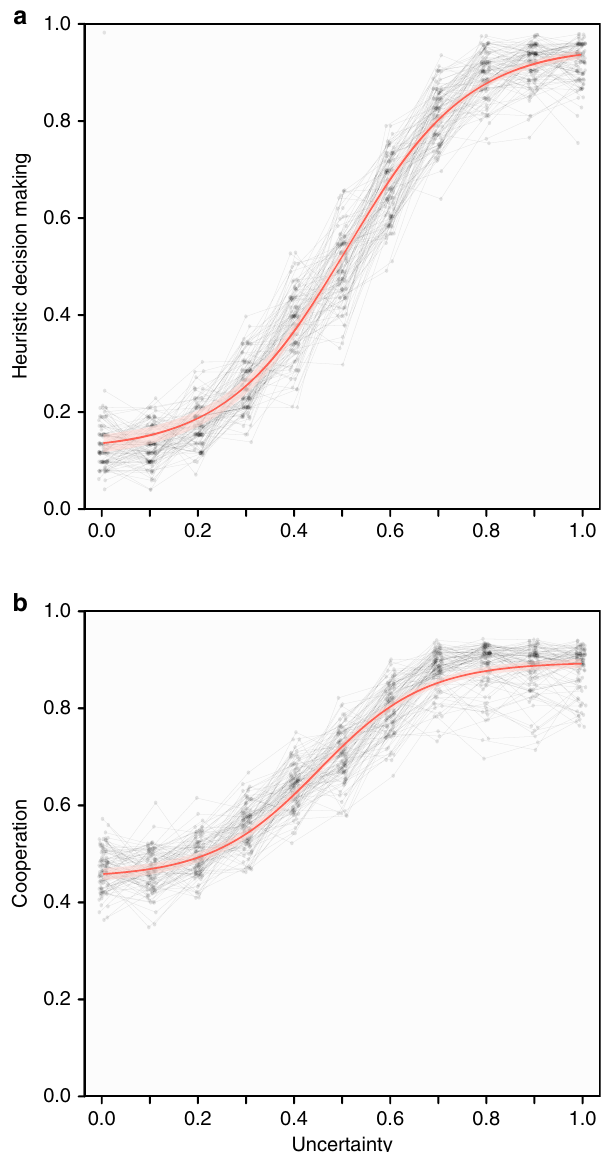
Fig. 2 Uncertainty about the nature of social interactions leads to the evolution of cooperative heuristics. a The fraction of individuals using heuristic strategies and b the average cooperation rate at the end of evolutionary simulations that impose varying levels of uncertainty about social interactions. Grey lines show separate results for 100 different random mutation matrices that determine the probability with which a mutation of each strategy gives rise to each other strategy (every point shows an average over 50 replicate simulations per mutation matrix). The red line and shading provide the estimate of the mean and 95% con fi dence interval of ( a ) heuristic decision making and ( b ) cooperation for the average mutation matrix (modelled as a four-parameter logistic function, see Methods for